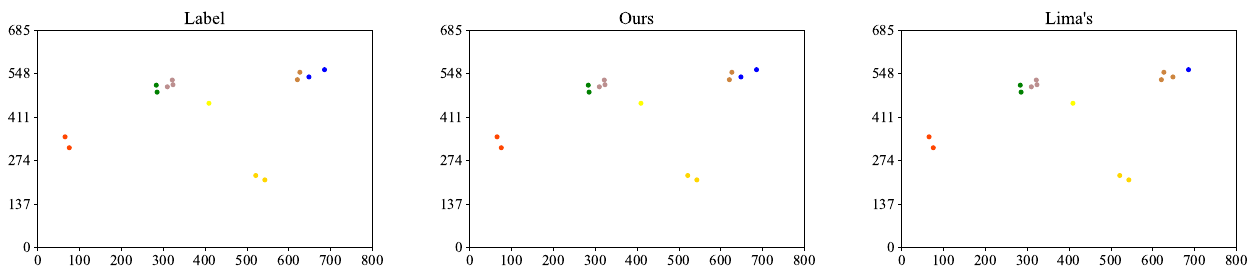
Figure 5. The 2D Comparison of the label, our and Lima’s methods (unit: cm). The colors differ among IDs.